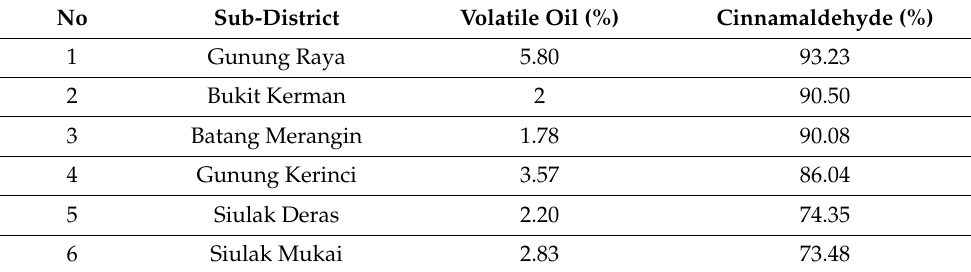
Table 5. Chemical contents of Korintjie cinnamon produced in six sub-districts.